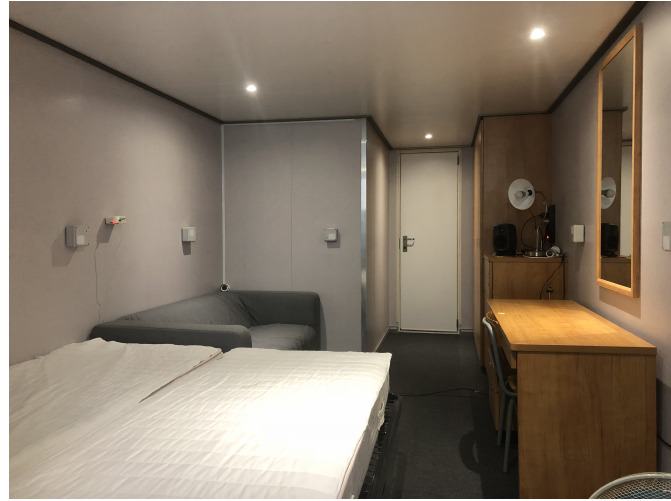
Figure 13. Cabin environment. The Demo Cabin was provided by Fincantieri